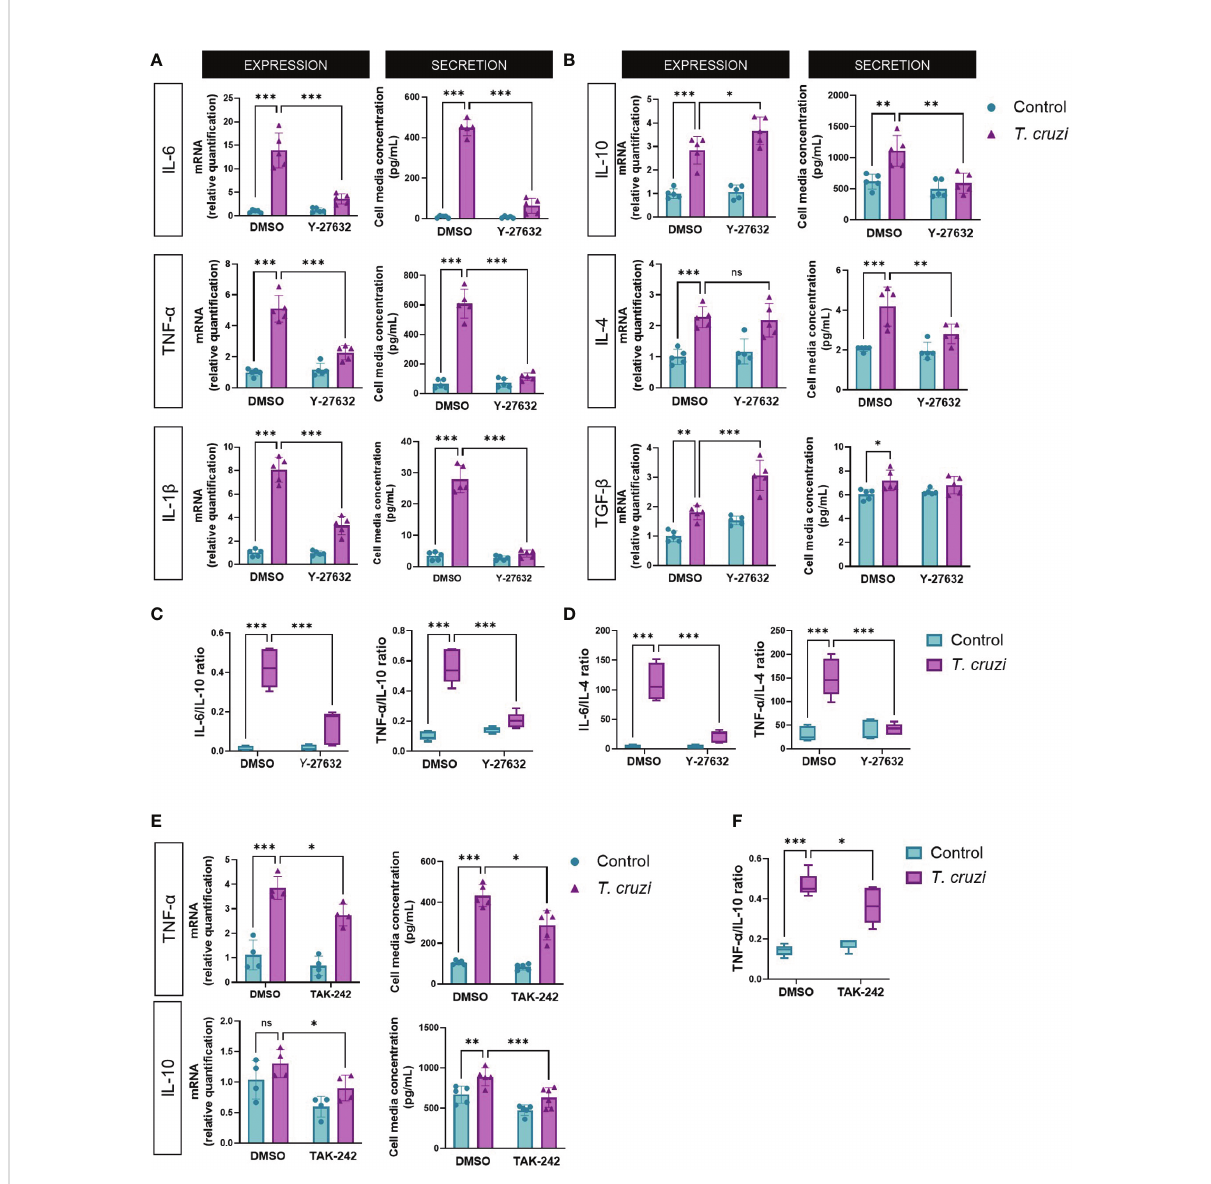
FIGURE 2 ROCK and TLR4 inhibition decrease M1 phenotype in T. cruzi -infected macrophages. PMA-induced U937 cells were incubated with the ROCK inhibitor Y-27632 or DMSO as vehicle control for 60 min and then incubated with or without T. cruzi for 30 min. After 6 h post-infection, total RNA was extracted for RT-qPCR analysis, and 24 h post-infection, cell medium was collected for Multiplex analysis of the indicated M1 (A) and M2 (B) markers. (C) Secreted IL-6 and TNF- a to IL-10 ratios. (D) Secreted IL-6 and TNF- a to IL-4 ratios. (E) PMA-induced U937 cells were incubated with the TLR4 inhibitor TAK-242 or DMSO as vehicle control for 60 min and then incubated with or without T. cruzi for 30 min. After 6 h post-infection, total RNA was extracted for RT-qPCR analysis, and 24 h post-infection, cell medium was collected for Multiplex analysis of cytokines. (F) Secreted TNF- a to IL-10 ratio. Data are expressed as mean ± SD of 5 independent experiments. *p<0.05, **p<0.01, ***p<0.001, analyzed by two-way ANOVA and Tukey post-test. ns, non signi fi